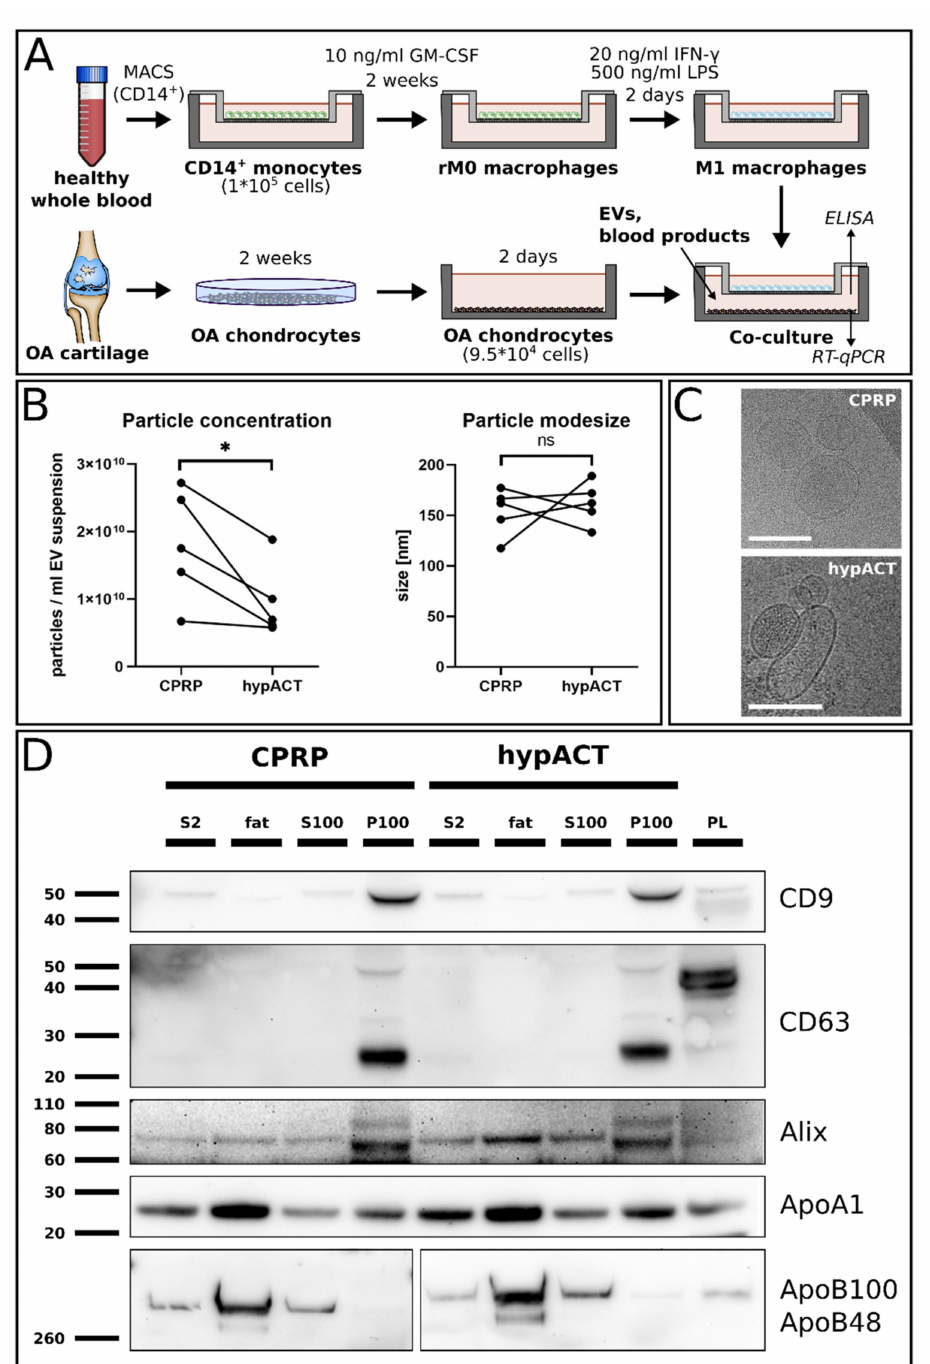
Figure 1. ( A ) Schematic overview of the procedure to set up the co-culture model. ( B ) Characterization of the concentration and mode size of EVs enriched via UC, analyzed via NTA. ( C ) Visualization of EVs via cryo-electron microscopy (scale bars: 200 nm). ( D ) Protein profiling of enriched EVs screening for positive EV markers CD9, CD63, and Alix, as well as the negative markers ApoA1 and ApoB100/48. S2: precleared blood product as input material; fat: buoyant layer after UC; S100: supernatant after UC; P100: pellet after UC; PL: platelet lysate as positive control; *: p < 0.05; ns: not significant. To confirm the differentiation of monocytes into macrophages, expression levels of p21 and inducible nitric oxide synthase (iNOS) were assessed via RT-qPCR (Figure 2A). These genes have been identified as markers of monocyte differentiation [47,48]. Undifferentiated monocytes did not show measurable iNOS expression in three out of six donors.